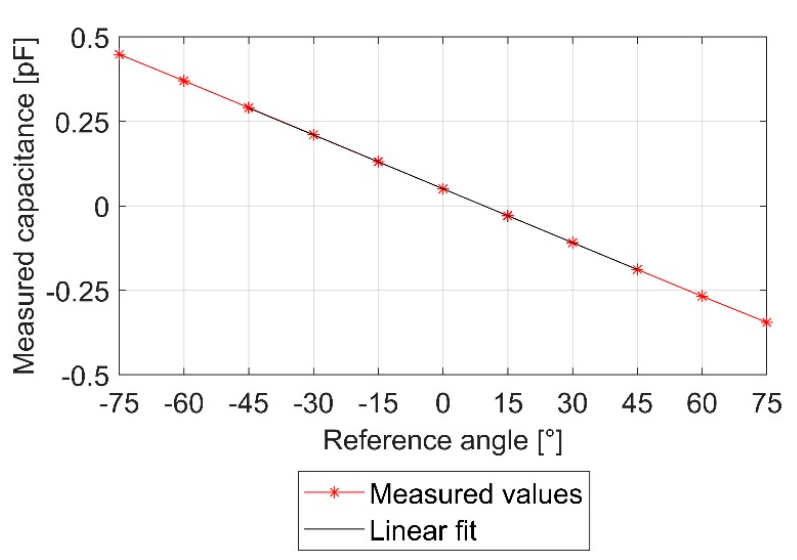
Figure 6. Characteristic curve MID with linear fit.